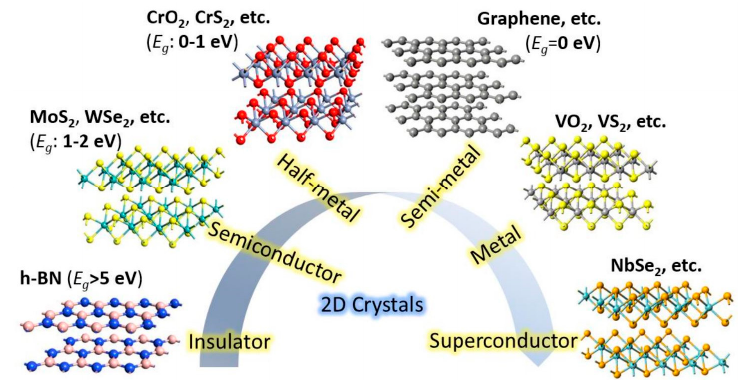
Figure 1. Different atomically thin layered 2D materials with disparate electrical properties ( E g denotes the band gap energy) Reprinted with permission from ref. [20]. Copyright 2014 Society of Photo-Optical Instrumentation Engineers (SPIE).